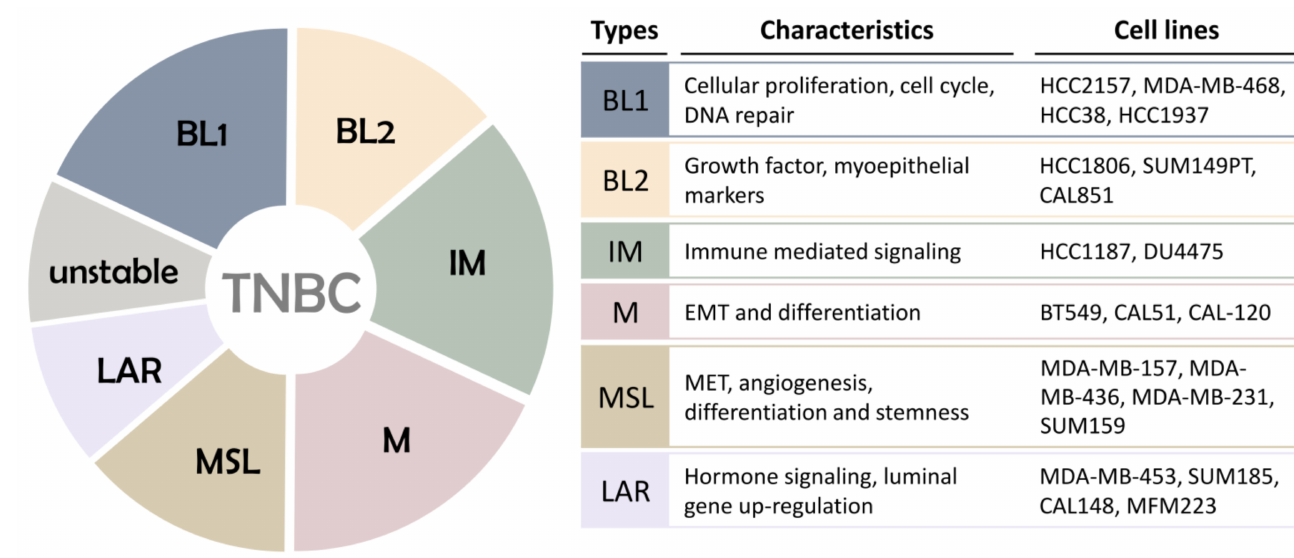
Figure 1. Association of different TNBC subtypes. TNBC gene expression subtypes are related to unique molecular characteristics and different TNBCs. Subtypes of TNBC: BL1, basal-like 1; BL2, basal-like 2; IM, immunomodulatory; ML, mesenchymal-like; MSL, mesenchymal stem-like; LAR, luminal androgen